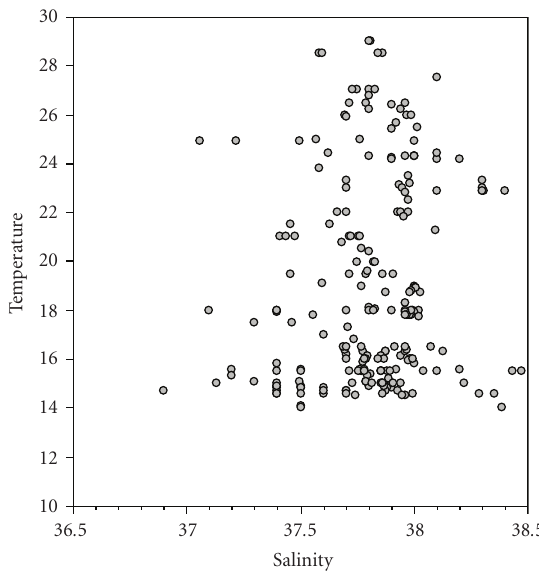
Figure 4: Temperature ( ◦ C) versus salinity (PSU Units) relationship at the sampling stations (autumn 2001–winter 2003).